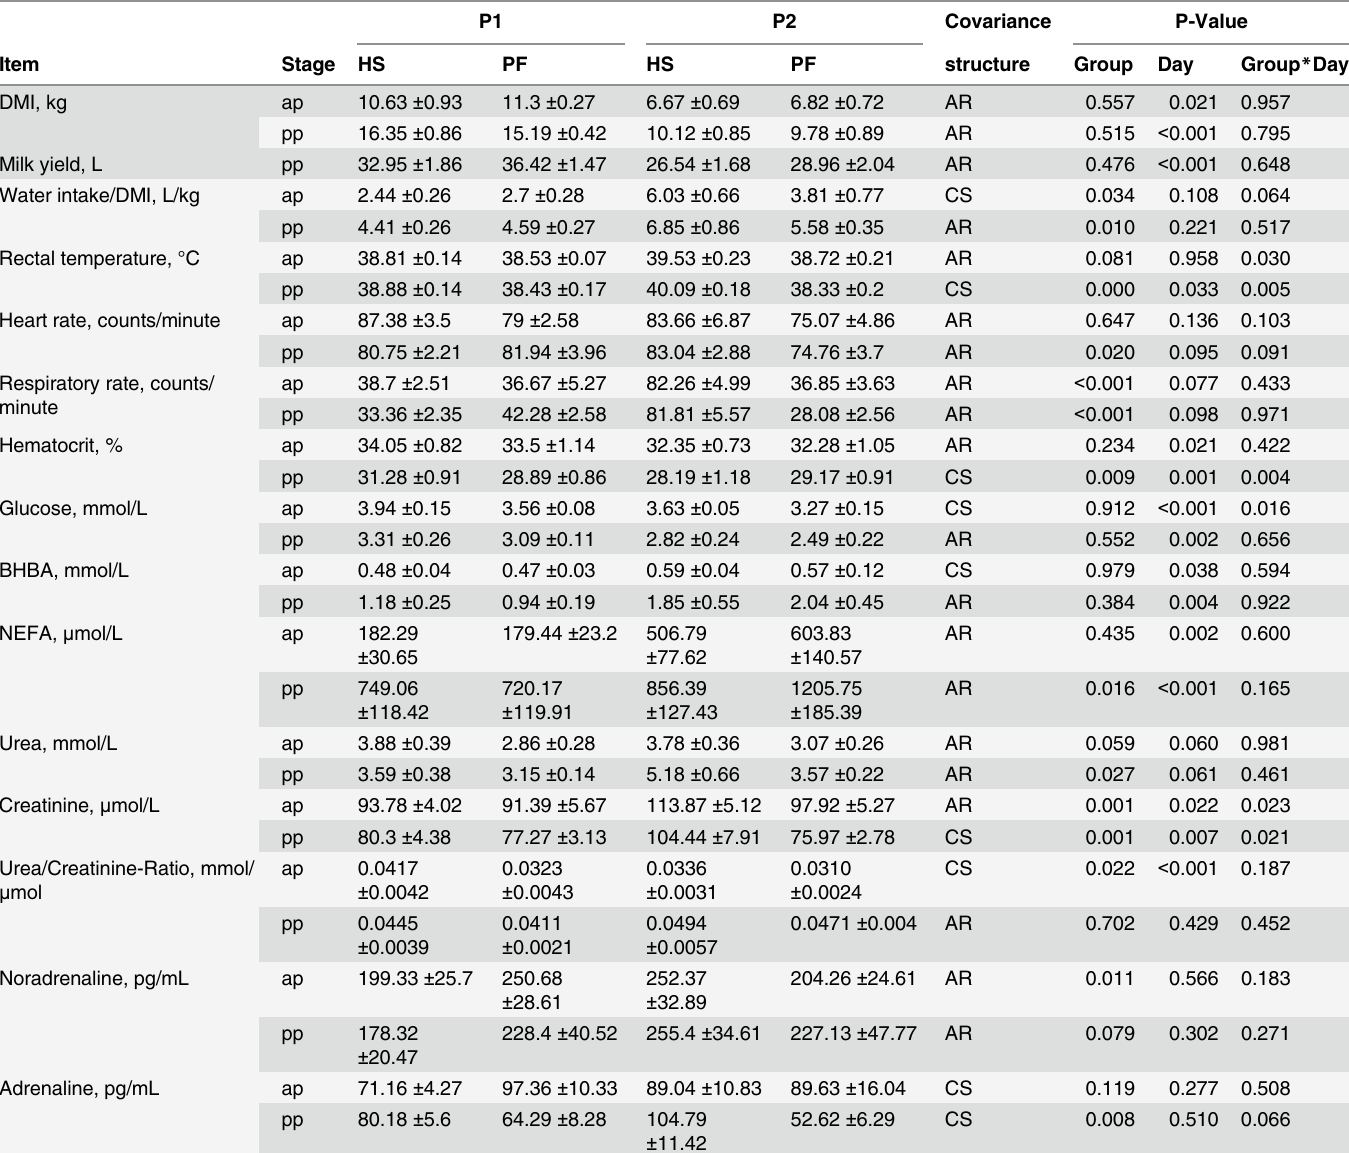
Table 3. Effects of heat stress (HS) or pair-feeding (PF) on nutritional, vital and metabolic